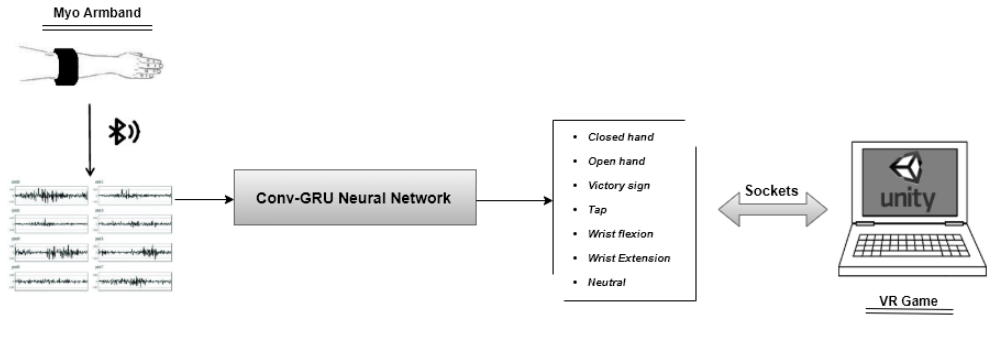
Figure 4. Proposed